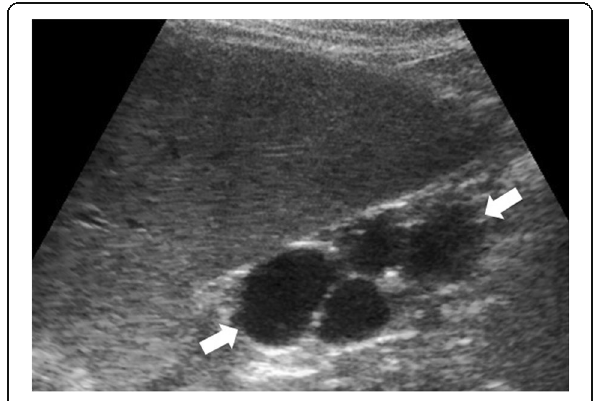
Fig. 18 Newborn with prenatally detected left kidney cysts underwent an US study on the first day of life. Sagittal view US image shows multiple cysts in the left renal fossa with no discernible normal renal parenchyma. The right kidney was normal (not shown). Imaging findings were found to be consistent with